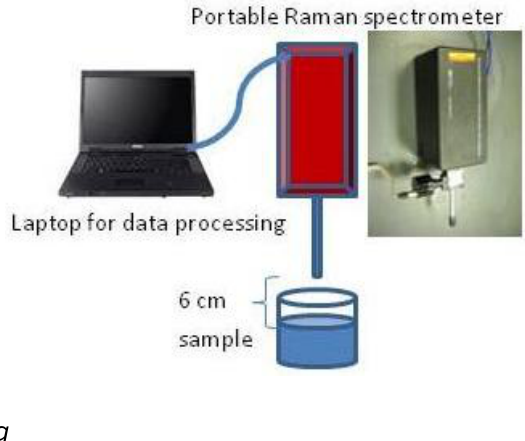
Figure 3. Schematic illustration of the experimental